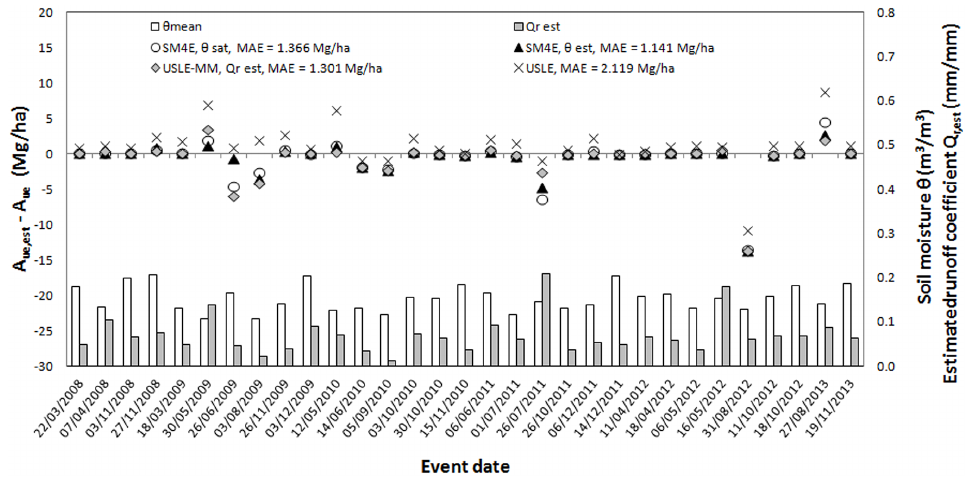
Figure 6. Comparison of the results obtained by the power SM4E model with both satellite and estimated soil moisture, the USLE-MM including predicted runoff, and the original USLE, in terms of deviations between estimated, A u e , est , and observed, A u e , soil losses. The values of the estimated runoff and of the mean soil moisture computed as the mean between the estimated and the satellite-retrieved values are also